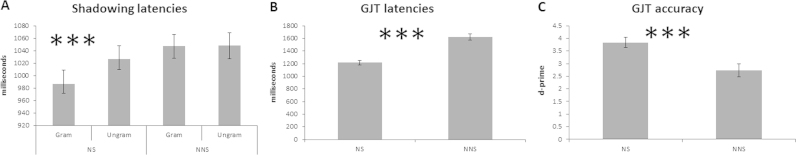
Means and standard error bars for behavioural tasks, A: shadowing experiment, B: GJT latencies, C: GJT accuracy (converted to d-prime).